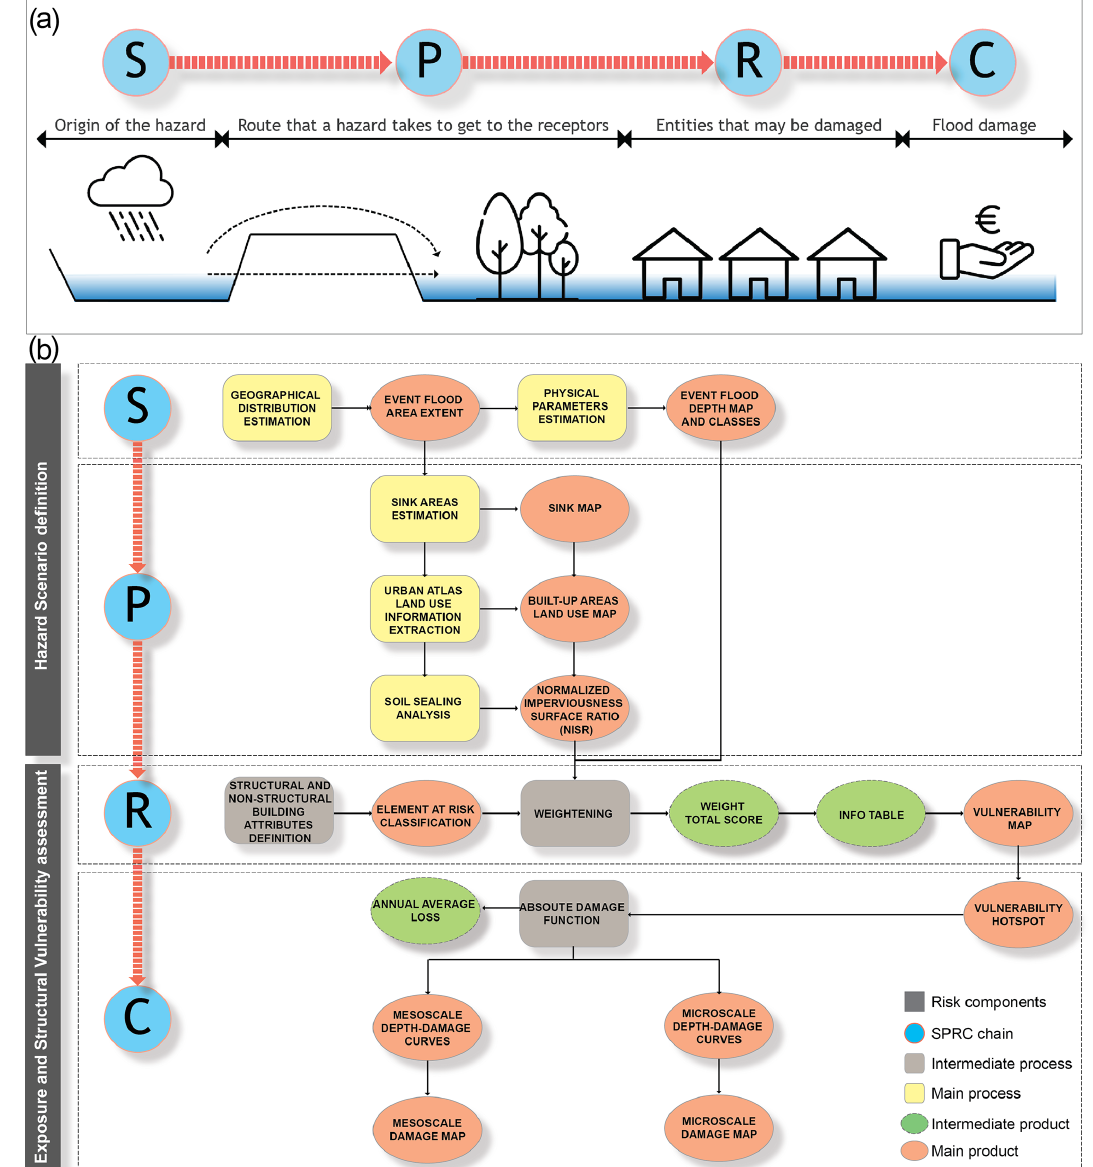
Figure 2. (a) SPRC conceptual model. (b) Structural vulnerability assessment procedure overview using a modified SPRC